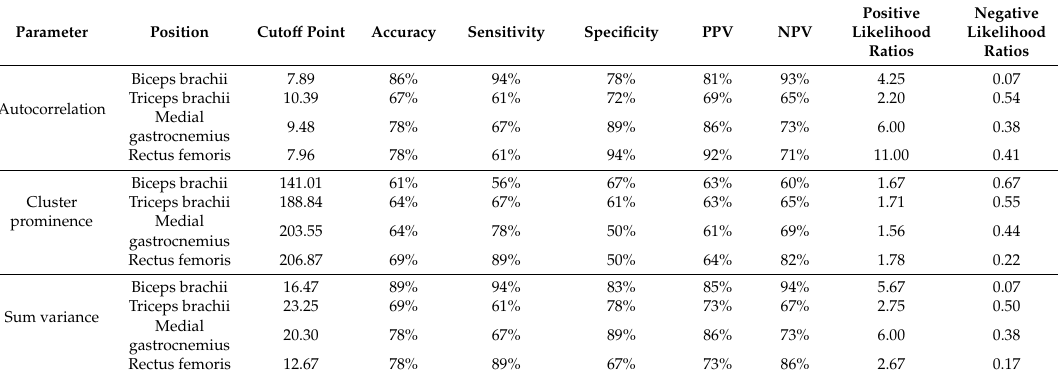
Table A1. The diagnostic performance for dynapenia based on the best cuto ff